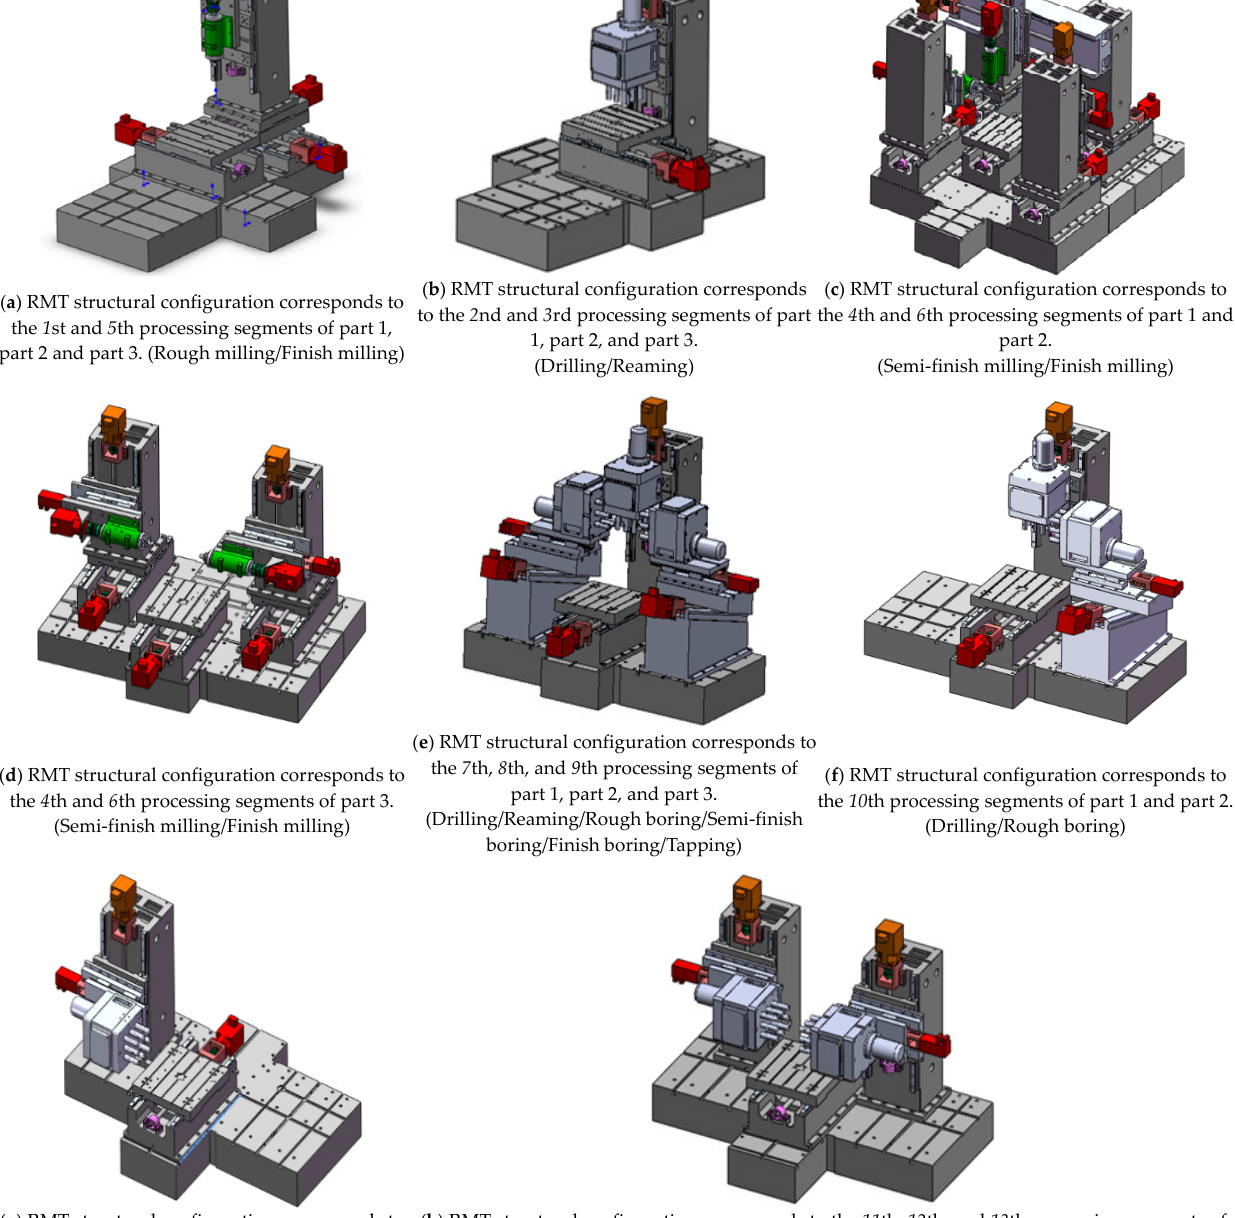
Figure 17. Several RMT structural configurations generated by the obtained three most-similar processing plans corre- sponding to part 1, part 2, and part 3, respectively.